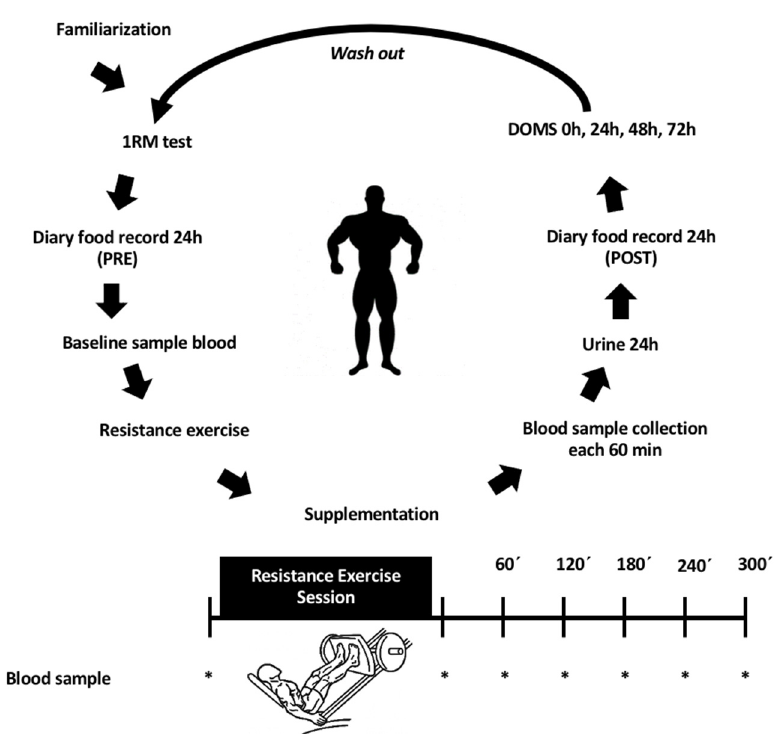
Figure 1. Protocol used during the experiment period. An acute, randomized, and double-blind trial. 1RM: One (1) maximum repetition; DOMS: Delayed onset muscle soreness assessment. Washout: a period of at least of one week.